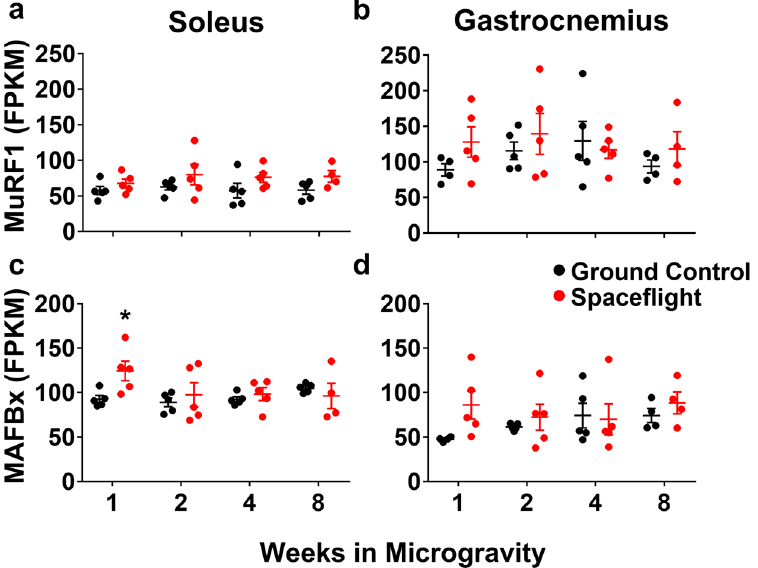
Figure 6. MuRF1 and MAFBx are not significantly up-regulated during a time course of microgravity exposure. Transcriptome profiling of the soleus ( a , c ) and gastrocnemius ( b , d ) showed that neither MuRF1 ( a , b ) nor MAFBx ( c , d ) were up-regulated with exposure to microgravity. Data are presented as mean FPKM values (n = 4–5/group). Unpaired t-test, Ground Control vs. Spaceflight. FPKM, fragments per kilo base per million mapped